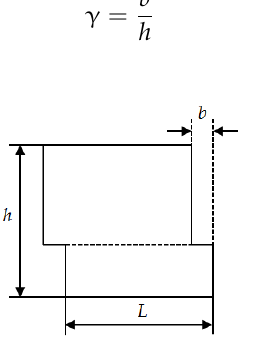
Figure 10. Relationship model between dislocation and shear strain. b : the value of Burgers vector b ; h: the width of element; L : the length of element.